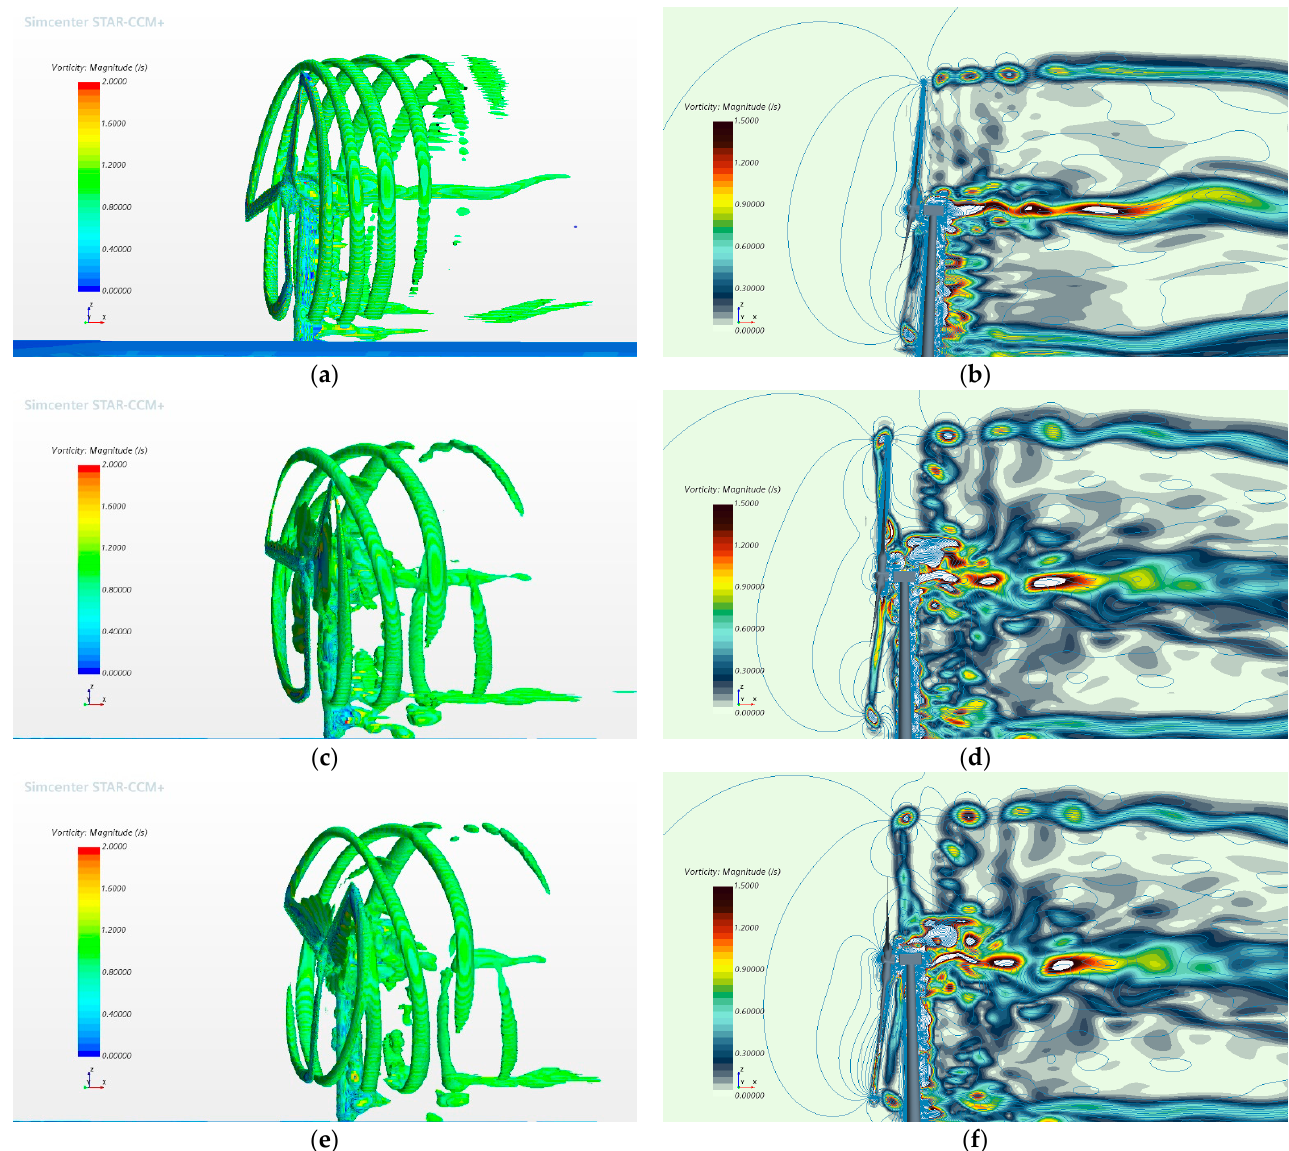
Figure 21. Wake scheme under combined motion with phase difference. ( a ) Iso-surface at T3 moment under case 20; ( b ) velocity in the symmetry plane at T3 moment under case 20; ( c ) iso-surface at T7 moment under case 22; ( d ) velocity in Table 7, moment under case 22; ( e ) iso-surface at T1 + T moment under case 22; ( f ) velocity in the symmetry plane at T1 + T moment under case 22.